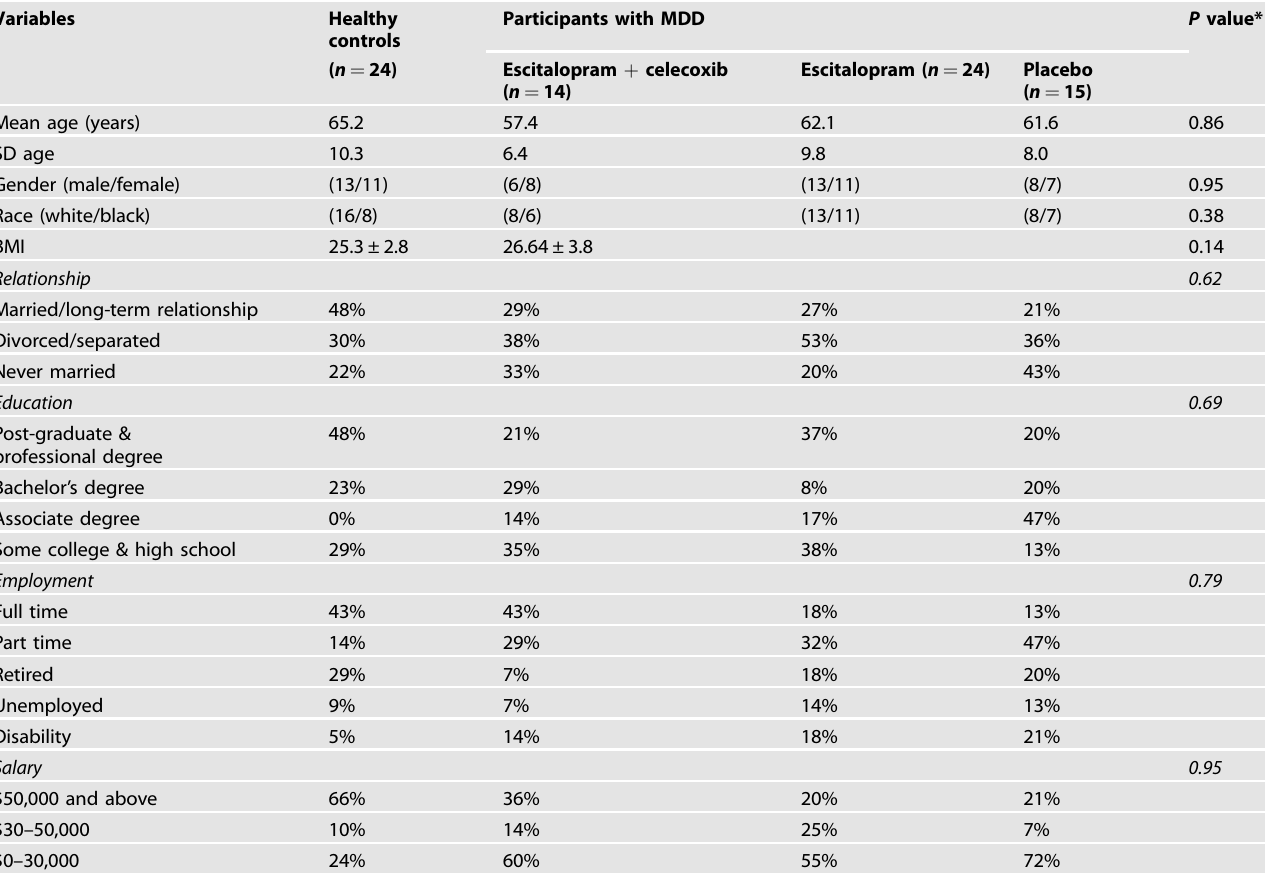
Table 2. Demographics of study